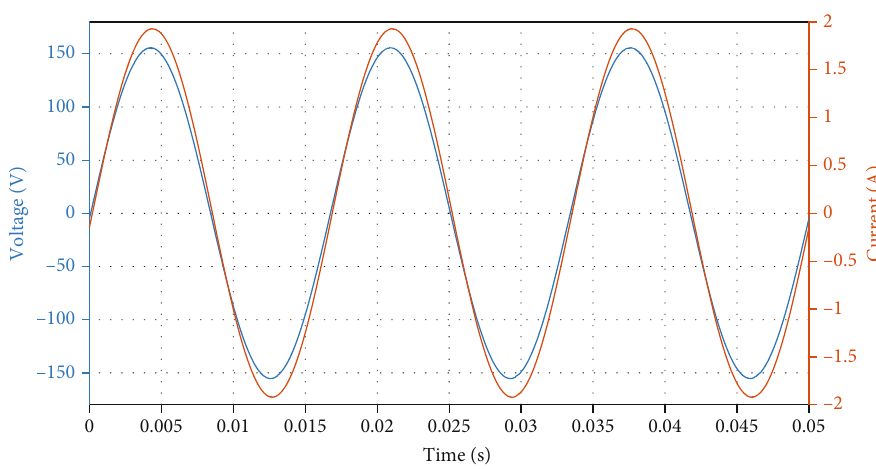
Figure 15: RL load simulation result. V